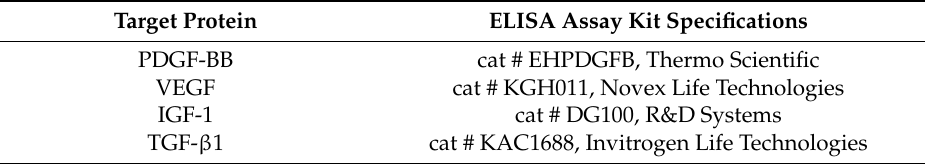
Table 6. Commercially-sourced ELISA kits used to quantify platelet growth